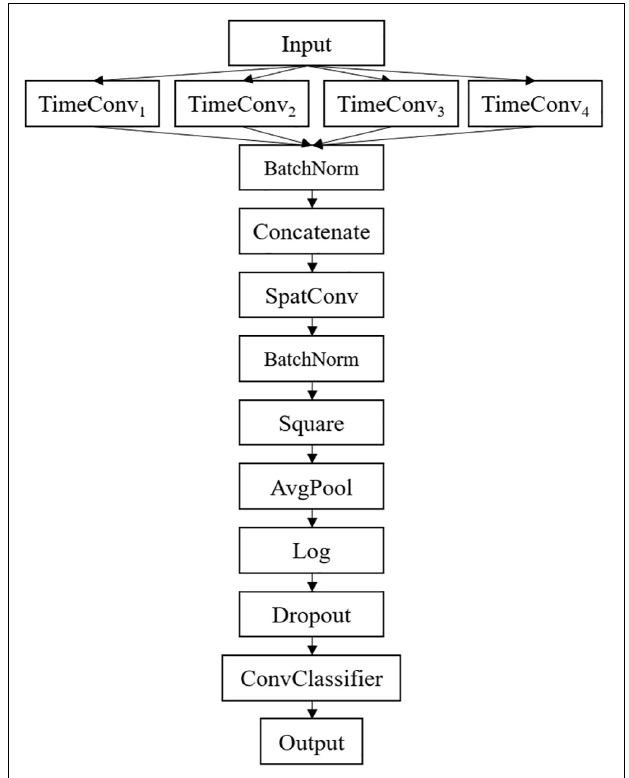
FIGURE 2 | Proposed MSFBCNN